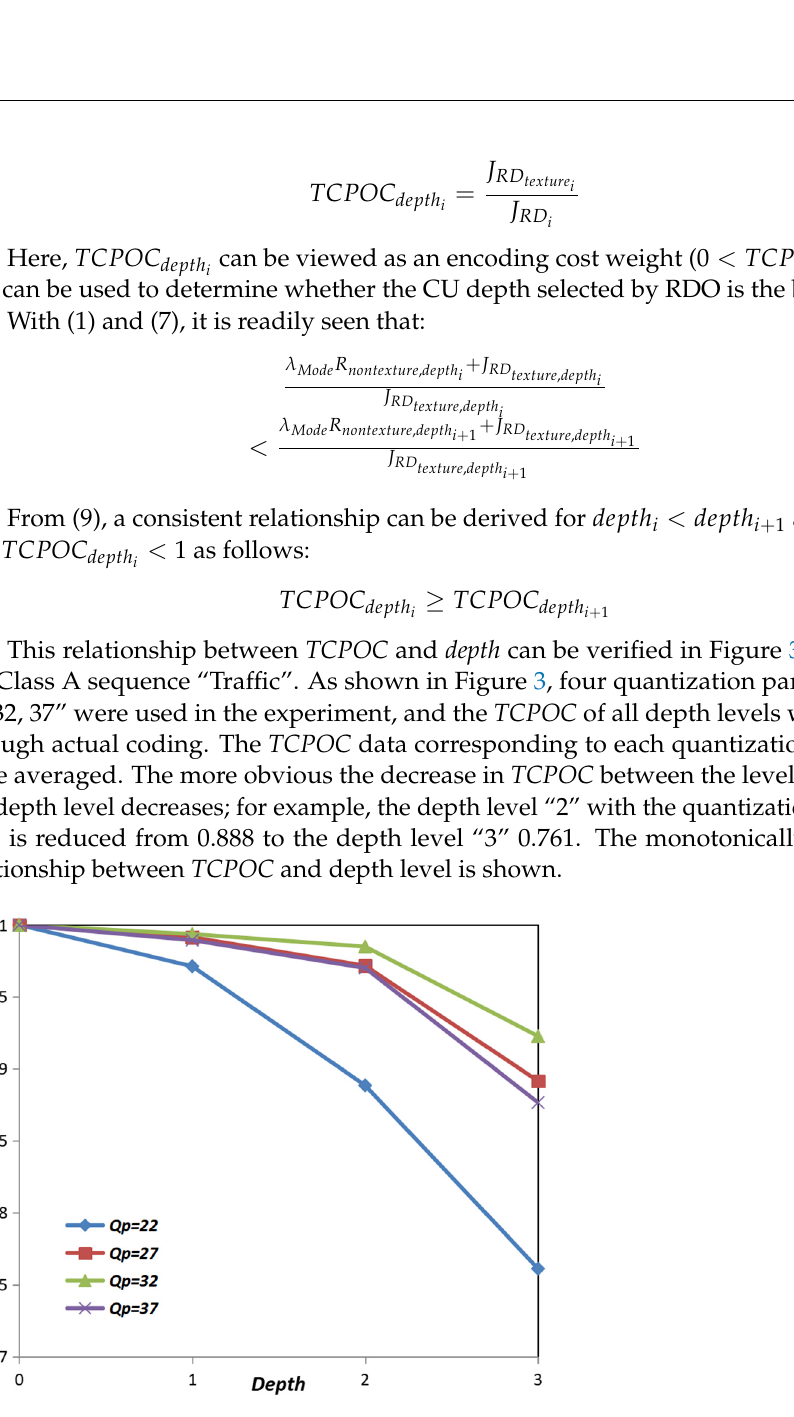
Figure 3. Relationship between TCPOC and depth for Class A sequence “Traffic” with different QP